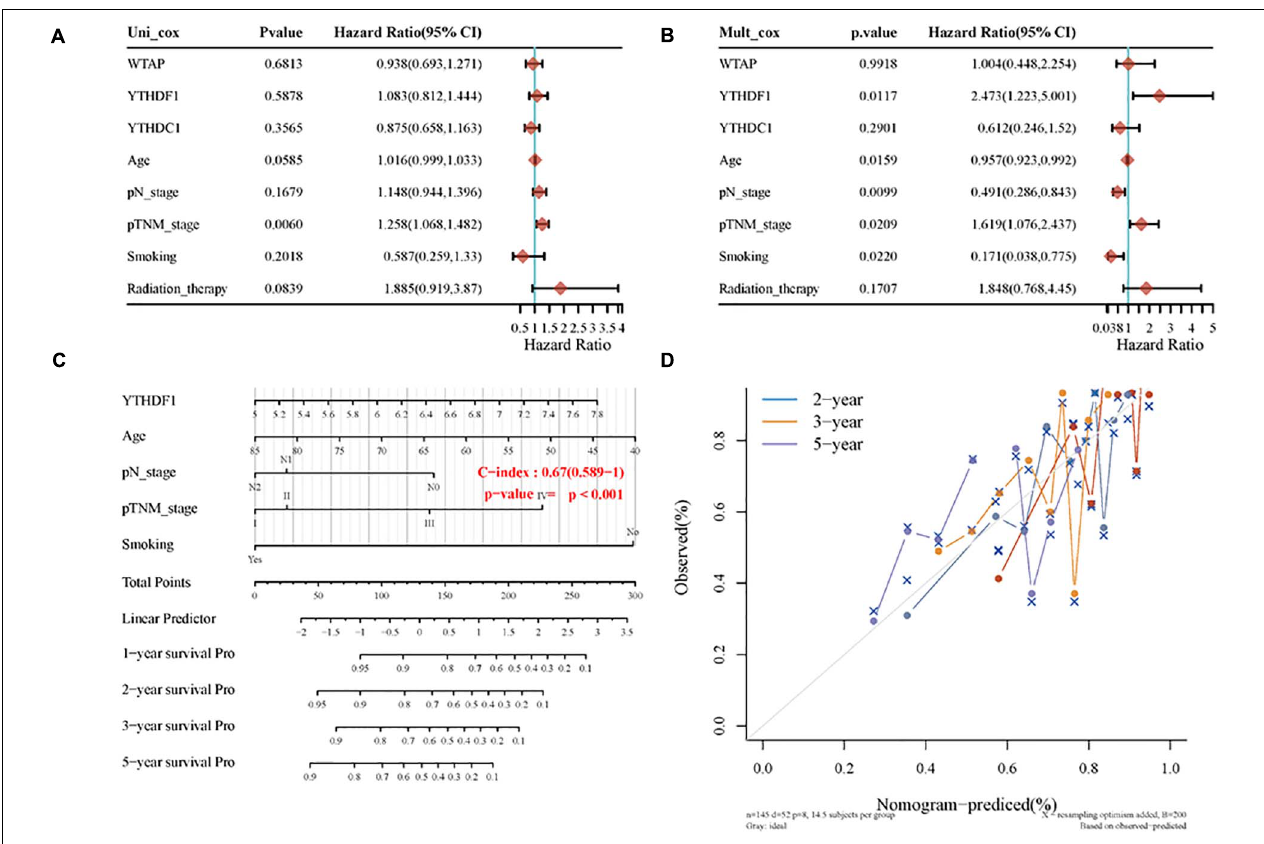
FIGURE 6 | The identification of prognostic factor for OS and the development of the nomogram. (A) Univariate Cox analysis. (B) Multivariate Cox analysis. (C) Nomogram for OS in LUSC patients. (D) The calibration curves for each